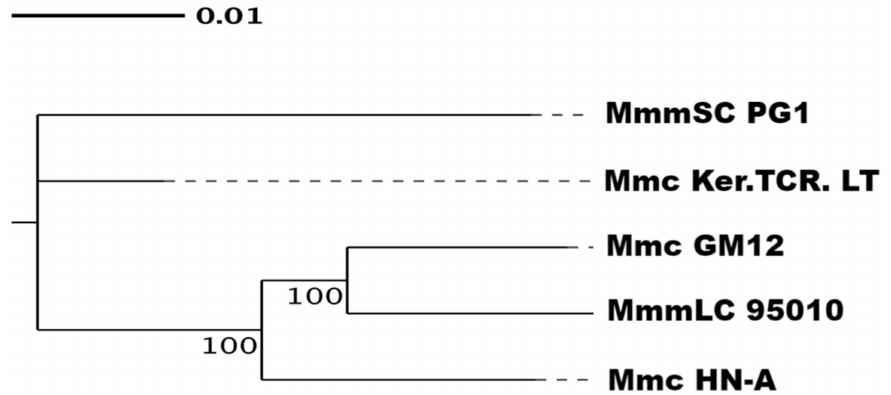
Figure 7. Species evolution tree based on characteristic genes. The phylogenetic tree shows the evolutionary relationships among different species and their topology. The end of the tree diagram is for each species. The intersection point is the common ancestor between species, and the branch length indicates the relative genetic distance between the species. The number on the branch indicates its reliability.